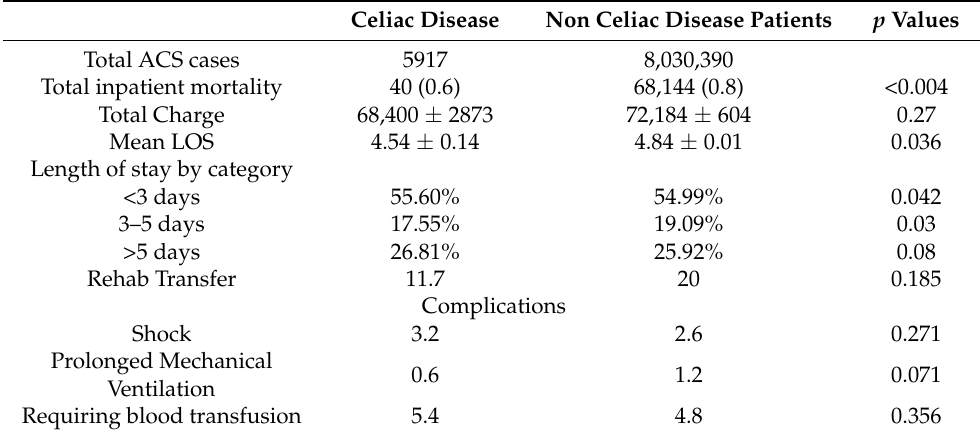
Table 2. Comparison of celiac disease and non-celiac disease